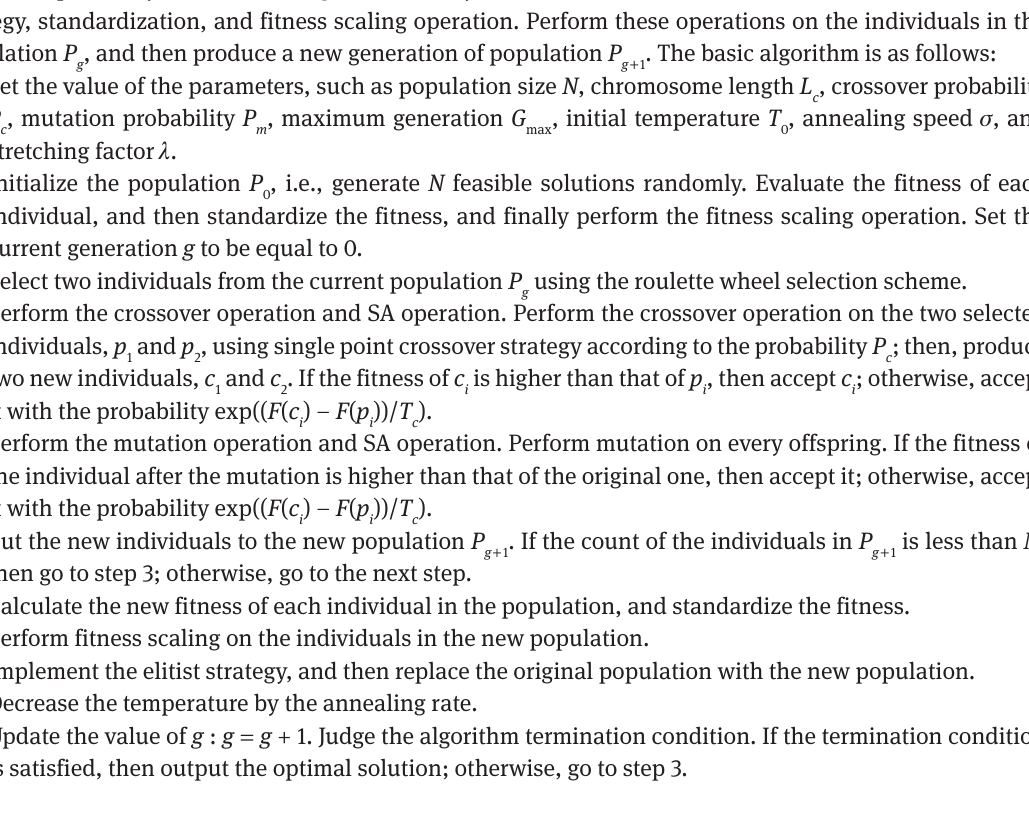
Table 2. Comparison of Selected Probability When T No. 1